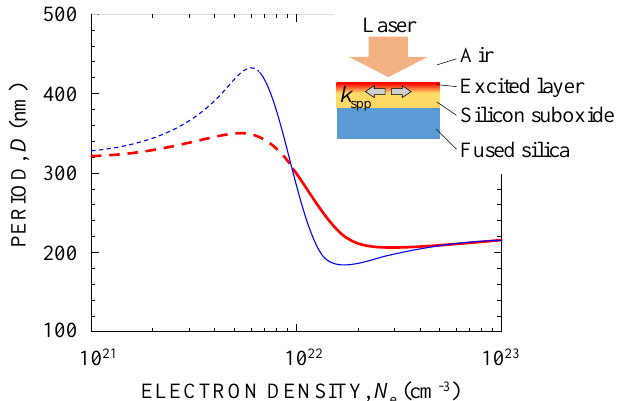
Figure 7. Period D of nanostructures calculated as a function of electron density N e . The thin blue and thick red curves denote D at the damping times of τ = 1 fs and τ = 0.5 fs, respectively. Excitation of SPPs is allowed in the region Re[ ε a ] < 0, where D is drawn with solid lines.